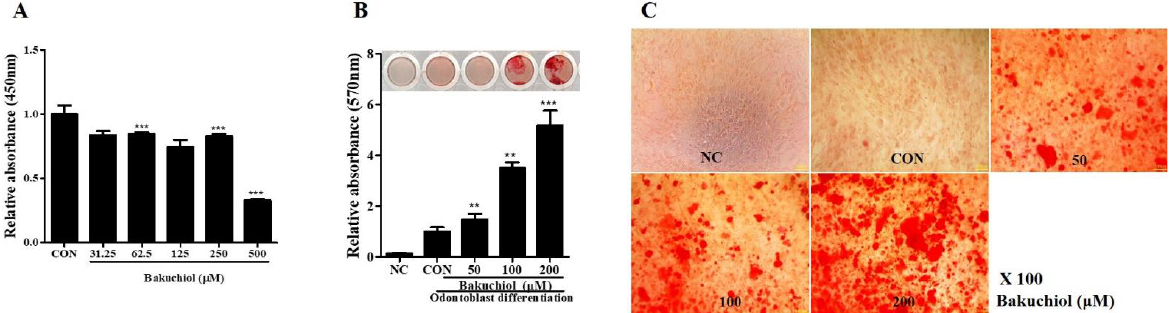
Figure 3. The effect of bakuchiol on proliferation and odontogenic differentiation in hDPSCs. ( A ) Cell proliferation was measured at 4 days using the CCK-8 assay. When treated with 50, 100 and 200 µ M of bakuchiol, cell proliferation was comparable to the control group. *** p < 0.01. ( B ) Alizarin red S (ARS) staining was performed on the 10th day of odontogenic differentiation of hDPSCs treated with bakuchiol. ( C ) Scanned images of plate wells are presented above the quantitation graph of ARS staining. All data are presented as the mean ± SEM (n = 3). ** p < 0.02, *** p < 0.01. ( C ) 100× microscope images of hDPSCs treated with 50, 100 and 200 μM of bakuchiol. SEM, standard error of mean; NC, negative control; CON, positive control; hDPSCs, human dental pulp stem cells. The expression of differentiation markers was observed after treatment with baku- chiol during odontogenic differentiation induction. Compared to that in the control groups, the expression of ALP, RUNX-2, OC, and DMP-1 and levels of the differentiation marker proteins DMP-1 and DSPP increased in the bakuchiol-treated groups (Figure 4).